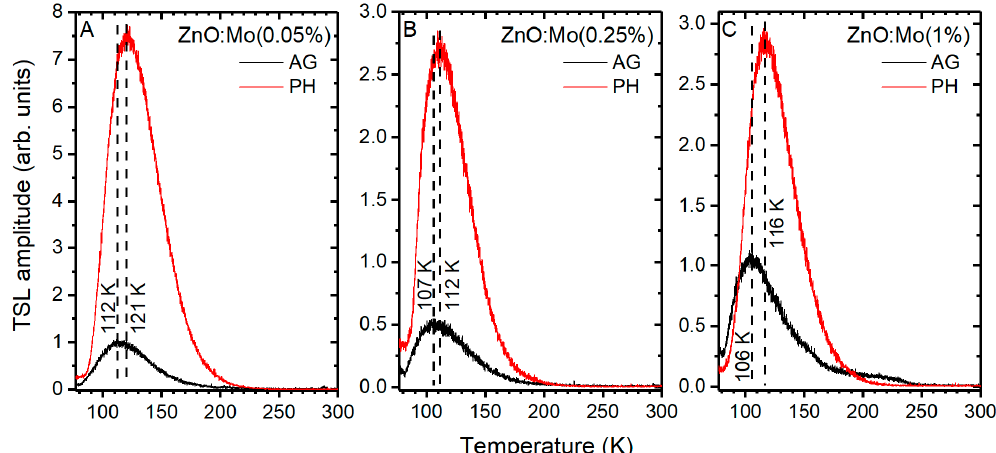
Figure 9. TSL glow curves of the ZnO:Mo(0.05%) ( A ), ZnO:Mo(0.25%) ( B ) and ZnO:Mo(1%) ( C ), AG and PH samples. Dashed vertical line segments are the eye guides to follow the glow peak positions.